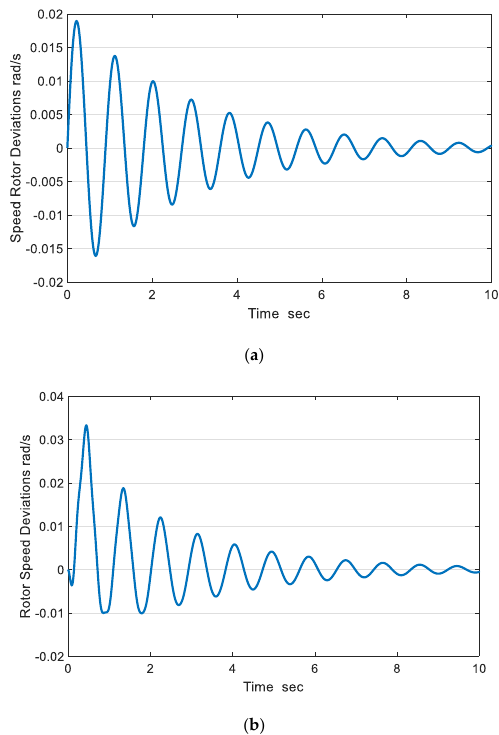
Figure 7. Time evolution after a unit step function applied to the transfer functions. ( a ) Linear transfer function; ( b ) second order transfer function.